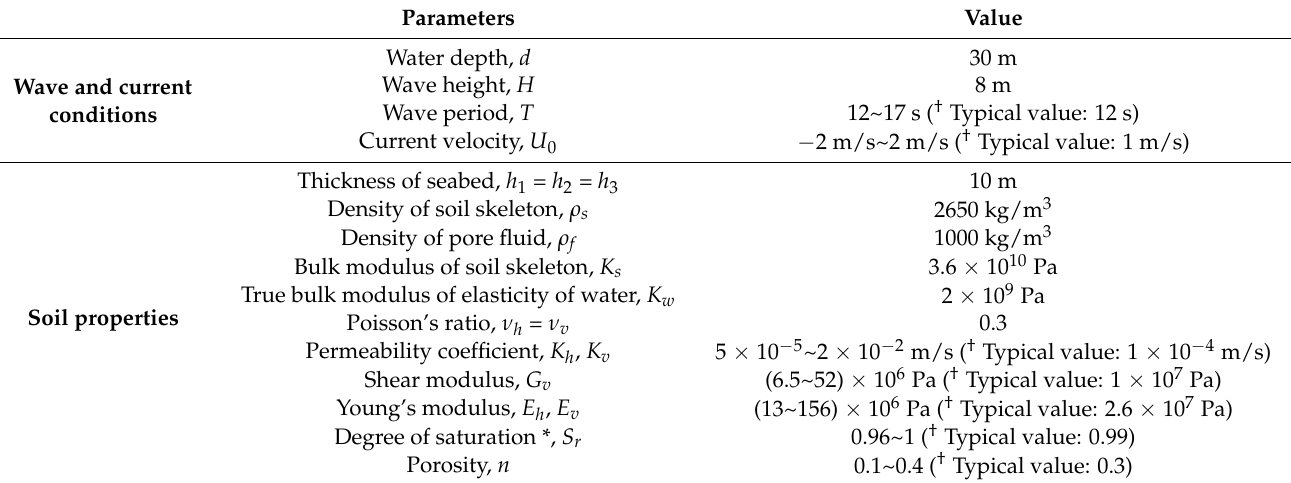
Table 3. Wave and current conditions and TIP soil